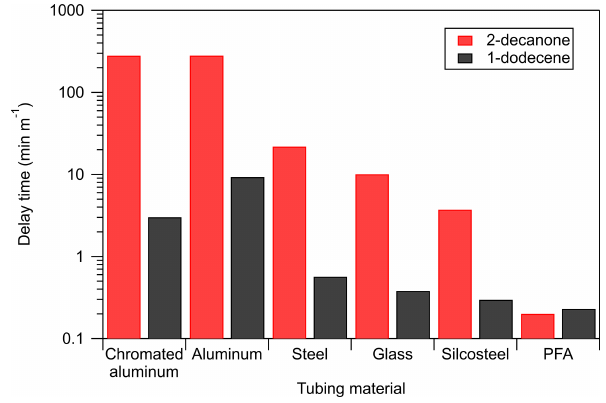
Figure 5. Comparison of measured tubing delay times for a ketone and an alkene of similar saturation concentration (2-decanone and 1-dodecene). All measurements were performed under dry condi- tions (RH < 0 . 5%) with 20ppbv of the standard in the VOC cham-